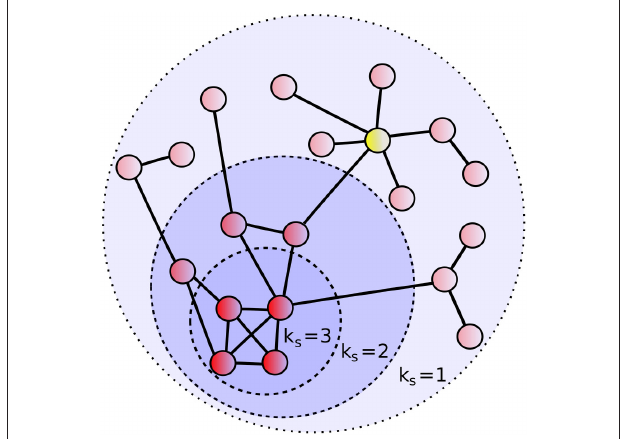
FIGURE 1 | Example of a k-shell structure. Nodes in the same k-shell have the same coreness centrality k s . A high degree is not a sufficient condition for a high coreness, for example for the case of the yellow